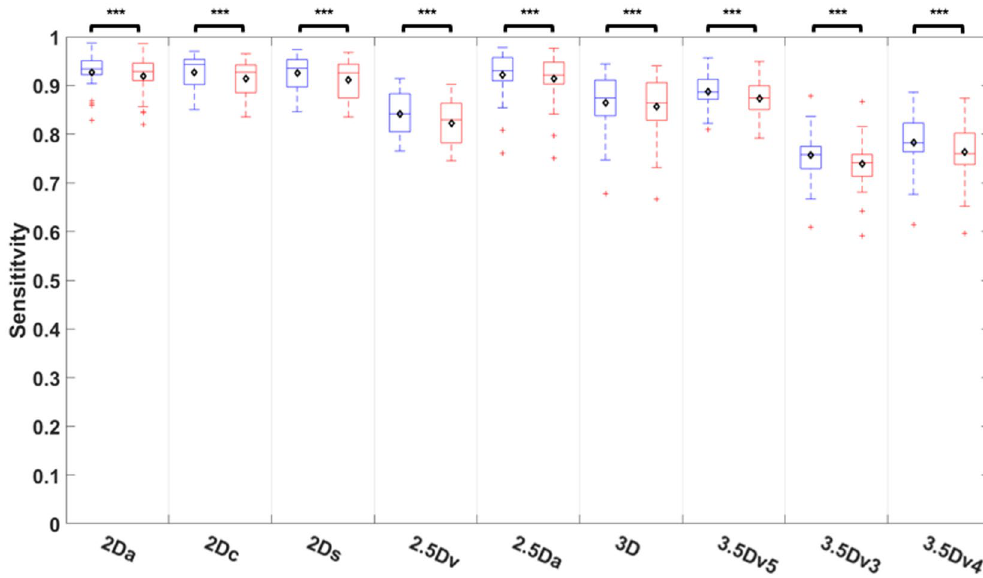
Figure 6. Comparison of sensitivity among 9 U-Nets before and after E&D.